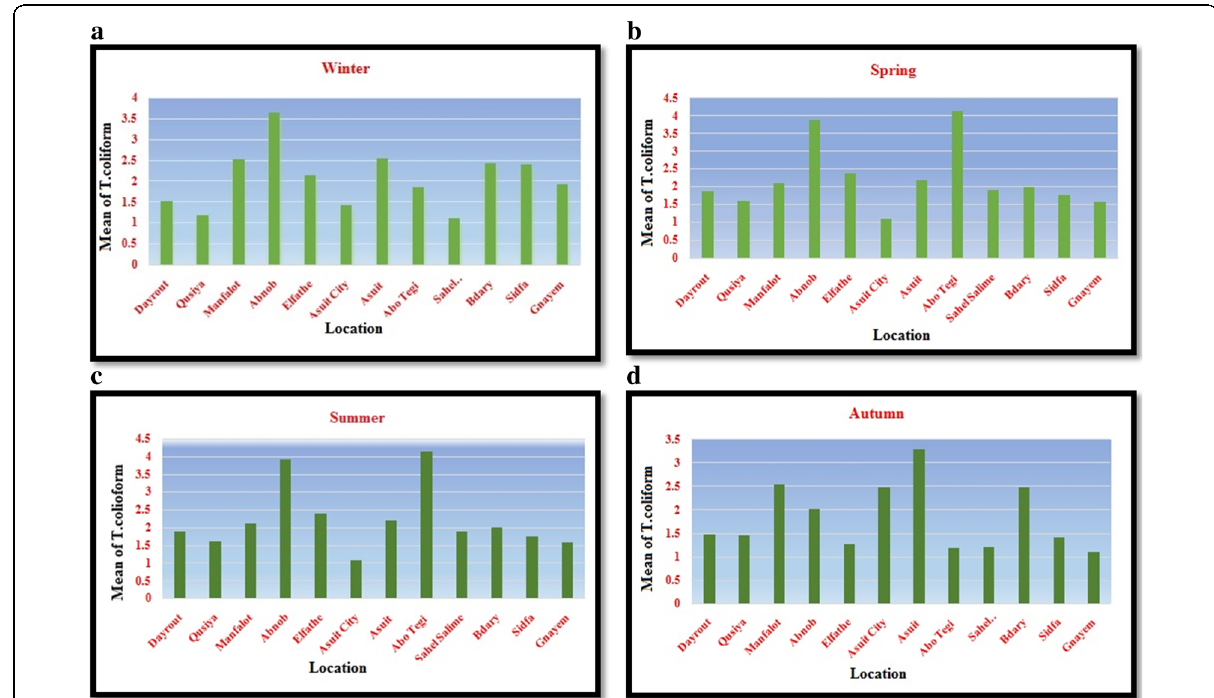
Fig. 15 Mean values of total coliform in the study area in a winter, b spring, c summer, and d autumn season from Jan 2017 to Nov 2017